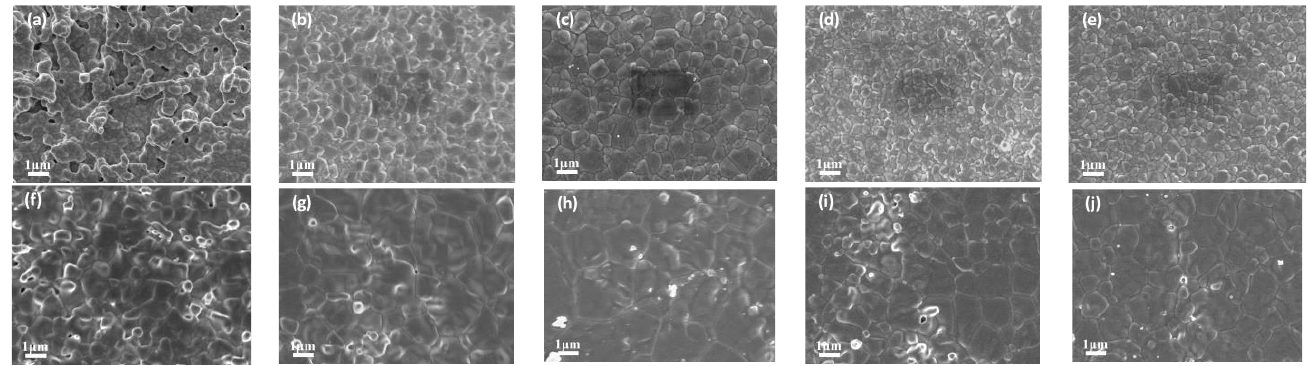
Figure 3. SEM under different sintering modes under 2 h holding time: ( a ) 5YSZ-1400 ◦ C, ( b ) 5YSZ- 1450 ◦ C, ( c ) 5YSZ-1500 ◦ C, ( d ) 5YSZ-1450-1400 ◦ C, ( e ) 5YSZ-1500-1400 ◦ C, ( f ) 8YSZ-1350 ◦ C, ( g ) 8YSZ- 1400 ◦ C, ( h ) 8YSZ-1450 ◦ C, ( i ) 8YSZ-1400–1350 ◦ C, ( j ) 8YSZ-1450–1350 ◦ Table 1. Sintered densities and grain size of 5YSZ and 8YSZ ceramics under various heating pa- rameters of two-step sintering.